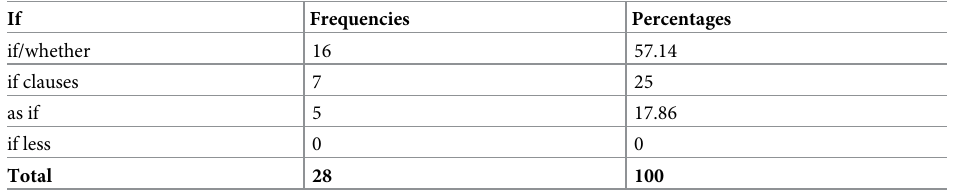
Table 10. Frequencies and percentages of